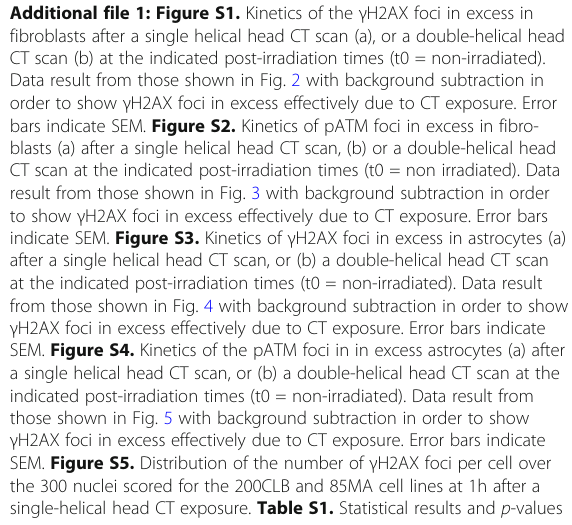
SEM. Figure S5. Distribution of the number of γ H2AX foci per cell over the 300 nuclei scored for the 200CLB and 85MA cell lines at 1h after a single-helical head CT exposure. Table S1. Statistical results and p